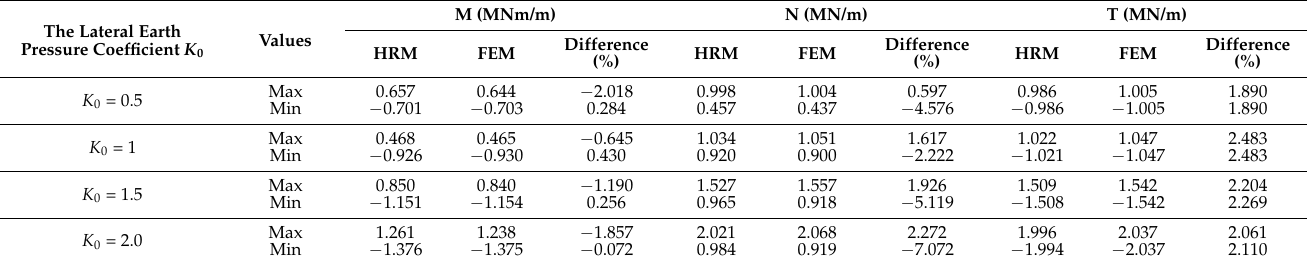
Table 4. Influence of the coefficient of lateral earth pressure K 0 on the internal